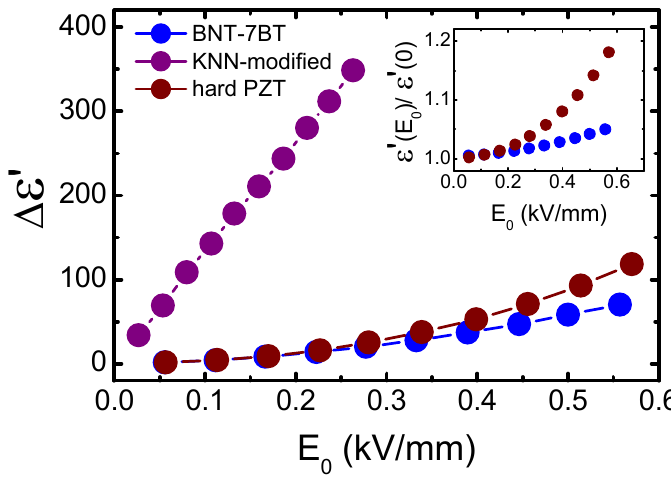
Figure 8. Increments of the dielectric constant as a function of the applied electric field amplitude for (K 0.44 Na 0.52 Li 0.04 )(Nb 0.86 Ta 0.10 Sb 0.04 )O 3 (KNN ‐ modified), 0.93(Bi 0.5 Na 0.5 )TiO 3 –0.07BaTiO 3 (BNT ‐ 7BT) and Pz26 (hard commercial PZT, from Ferroperm). The inset shows the relative increment of the dielectric constant for BNT ‐ 7BT and hard PZT.